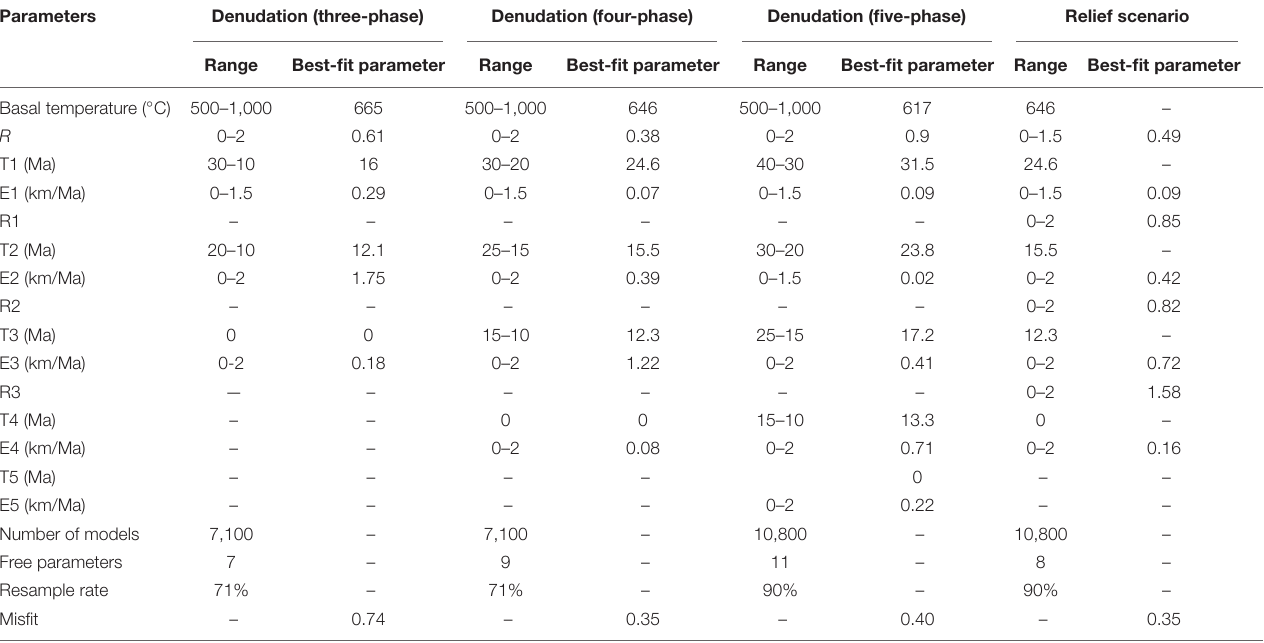
TABLE 1 | Values of parameters of input and inversion results. Parameters